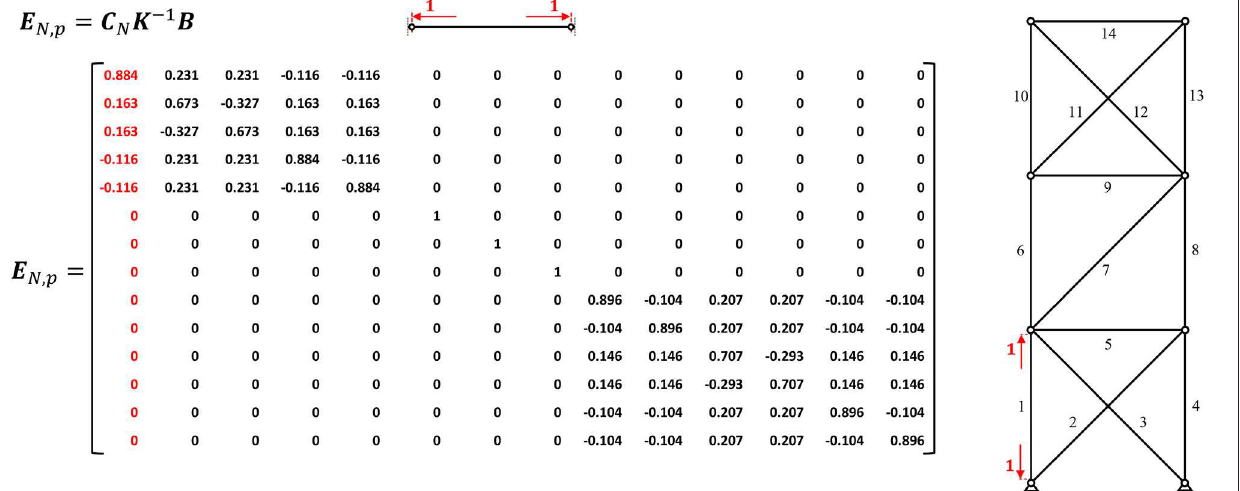
Frontiers in Built Environment |